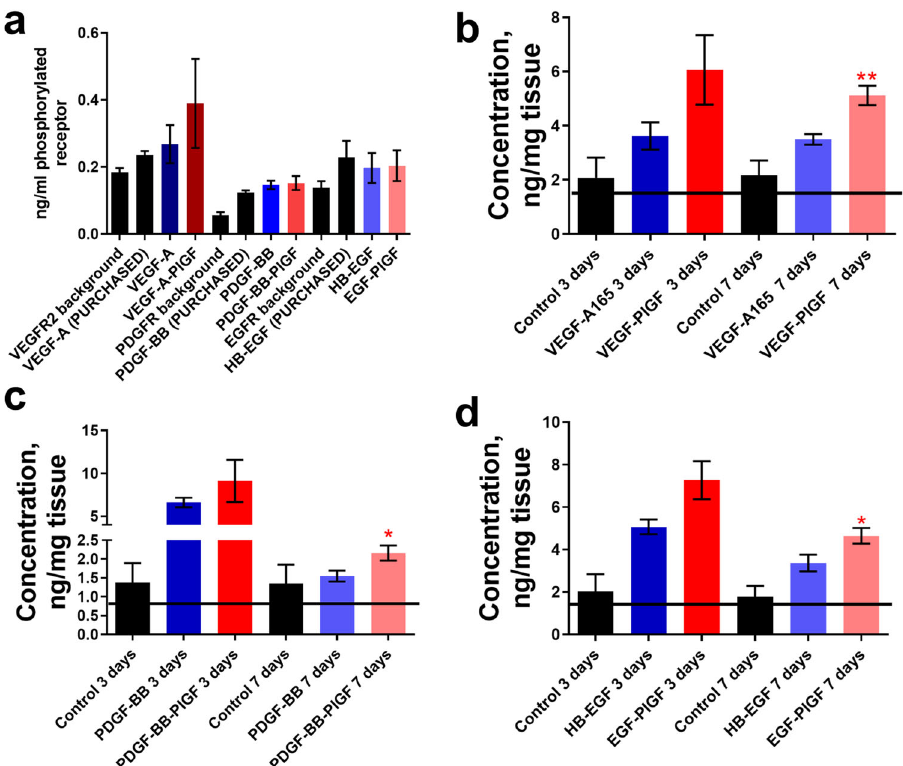
Fig. 2 Growth factors fused with the -PLGF-2 123 – 144 activate their cognate receptors at levels comparable to WT GF and remain in wound tissue longer than their wild-type (WT) counterpart. a 100 ng of VEGF-A-PlGF-2 123 – 144 , PDGF-BB-PlGF-2 123 – 144 , and HB-EGF-PlGF-2 123 – 144 caused corresponding receptor phosphorylation (VEGFR2, PDGFR, and EGFR, respectively) at the indicated amounts over 10 min on HUVEC cells (for VEGF-A165) or fi broblasts (for PDGF-BB and HB-EGF). Concentrations in wounded skin tissue (ng/mg) for ( b ) VEGF-A-PlGF-2 123 – 144